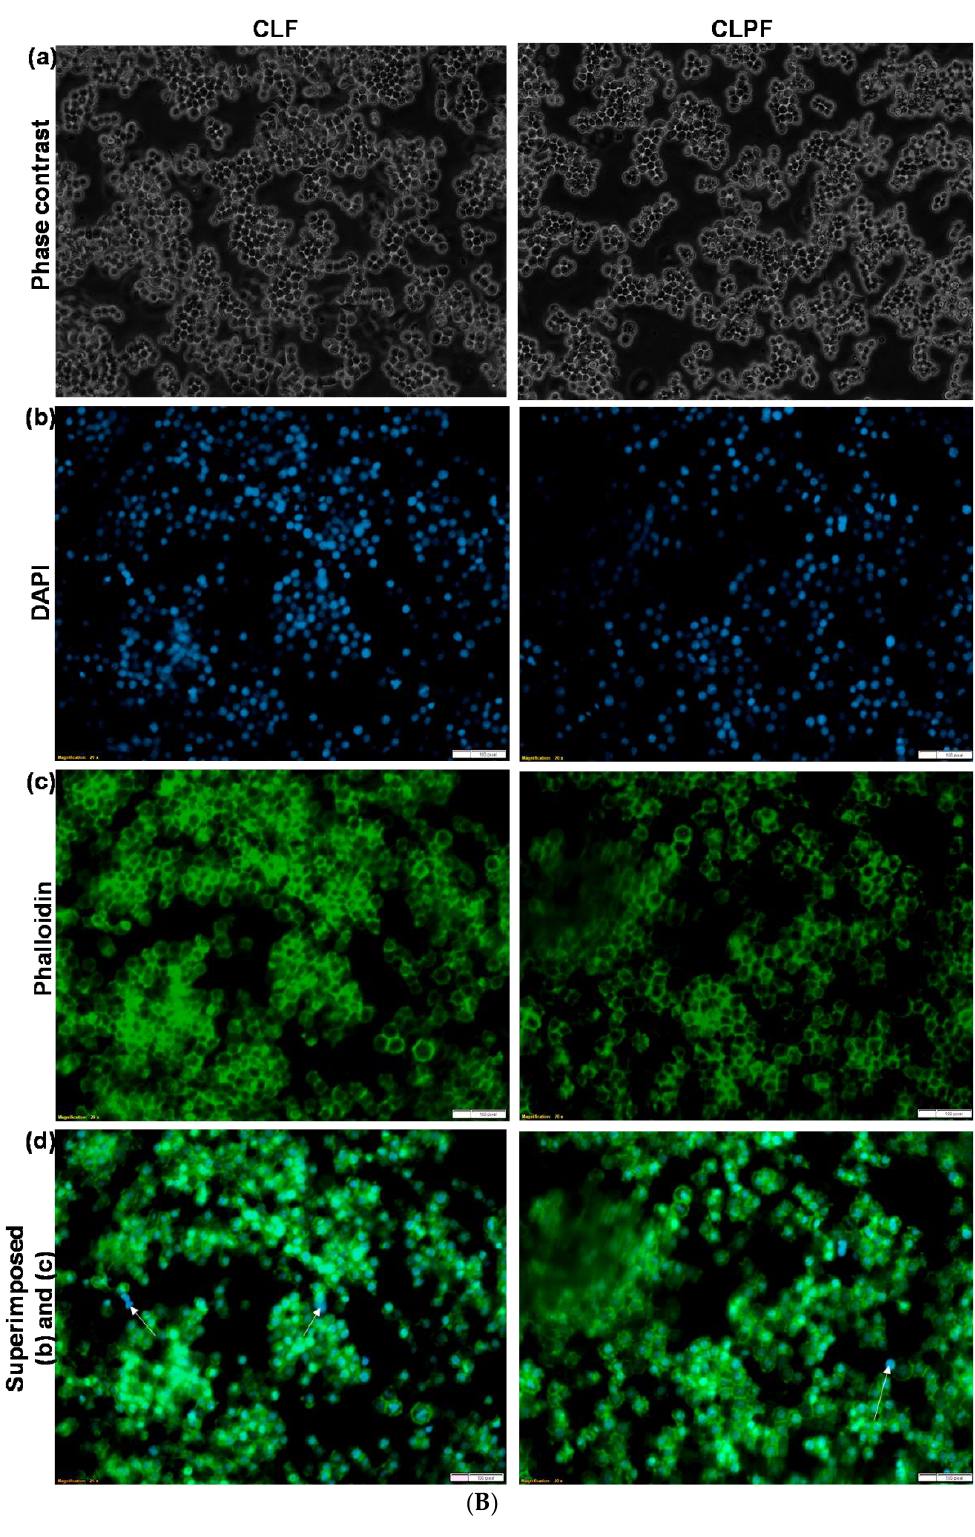
Figure 13. ( A ) Fluorescent microscopy images of RAW 264.7 macrophage cell morphology analysis ( a ) Phase contrast, ( b ) DAPI, ( c ) Phalloidin, and ( d ) Superimposed of ( b , c ) for untreated (control), cell treated with 90 µg/mL of PZQ and 5-FU (10 µg/mL) (negative control). Arrows denote dead cells. Scale bar: 100 µm; (×20 magnification). ( B ) Fluorescent microscopy images of RAW 264.7 macrophage cell morphology analysis: ( a ) Phase contrast, ( b ) DAPI, ( c ) Phalloidin, and ( d ) Superimposed of ( b , c ) with 90 µg/mL of CLF and CLPF. Arrows denote dead cells. Scale bar: 100 µm; (×20 magnification).